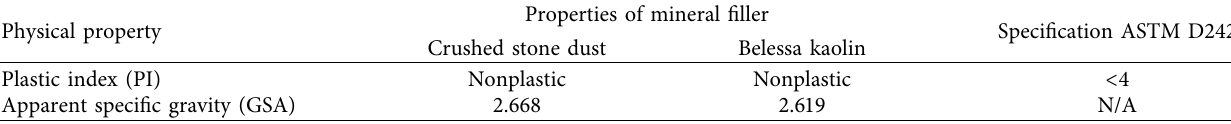
Figure 1: Flowchart of research design. Table 1: Physical properties of crushed stone aggregate (CSD) and Belessa kaolin.